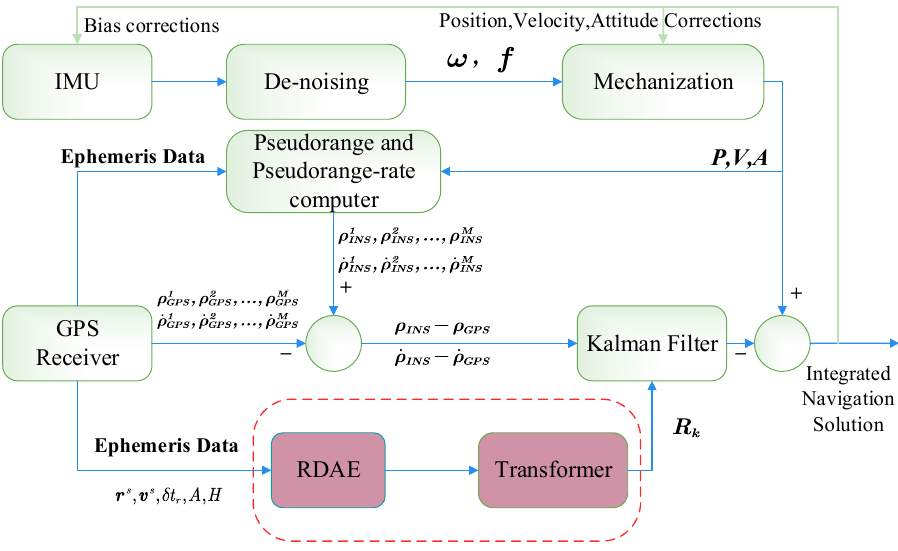
Figure 2. The flowchart of our proposed TC integration of GNSS/INS system.